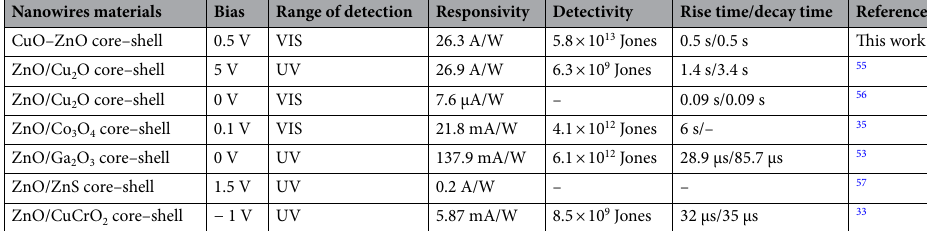
Table 1. Comparison of the performances of core–shell nanowire arrays based